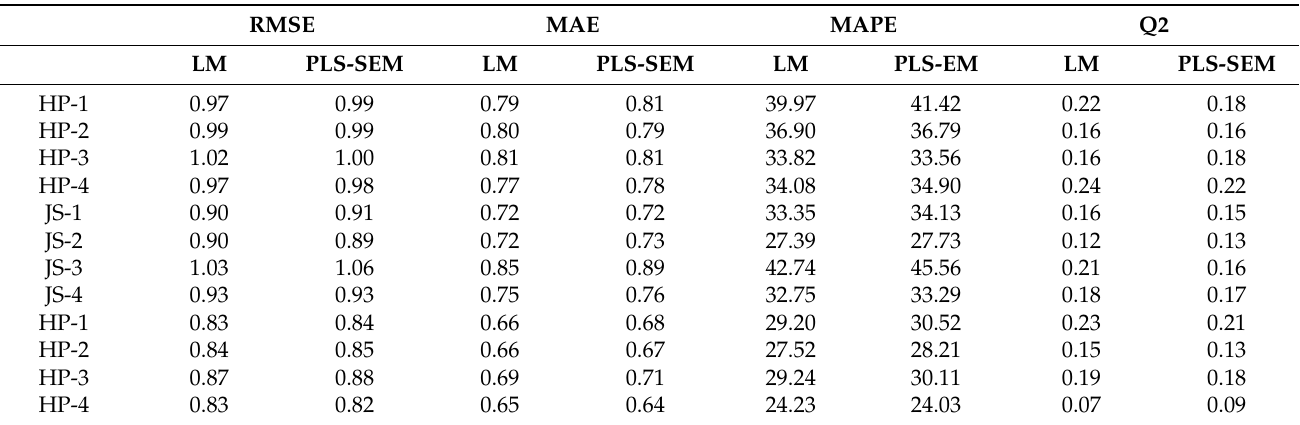
Table 6. PLS predict